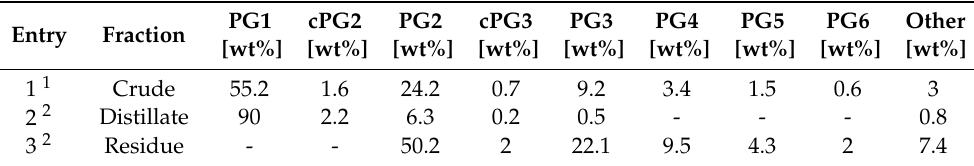
Table 4. Fractionation of the glycerol derivatives from optimized glycerol oligomerization via short path evaporation (GC